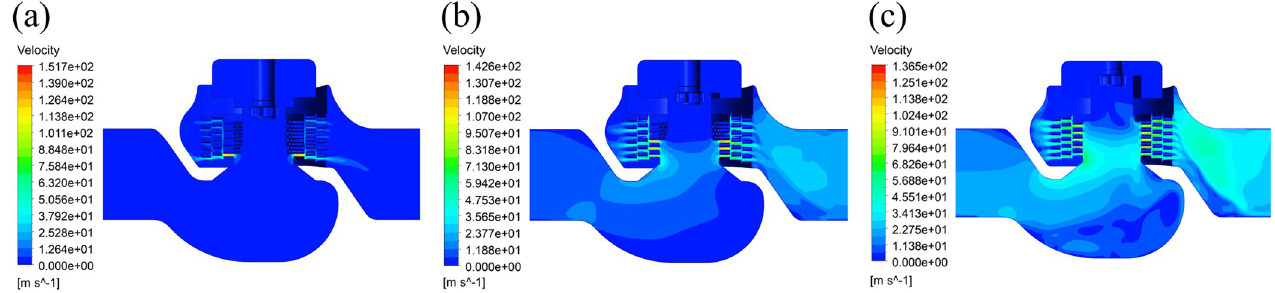
Fig 6. Velocity distributions of the flow field at different openings. (a) 10% opening. (b) 50% opening. (c) 100% opening.